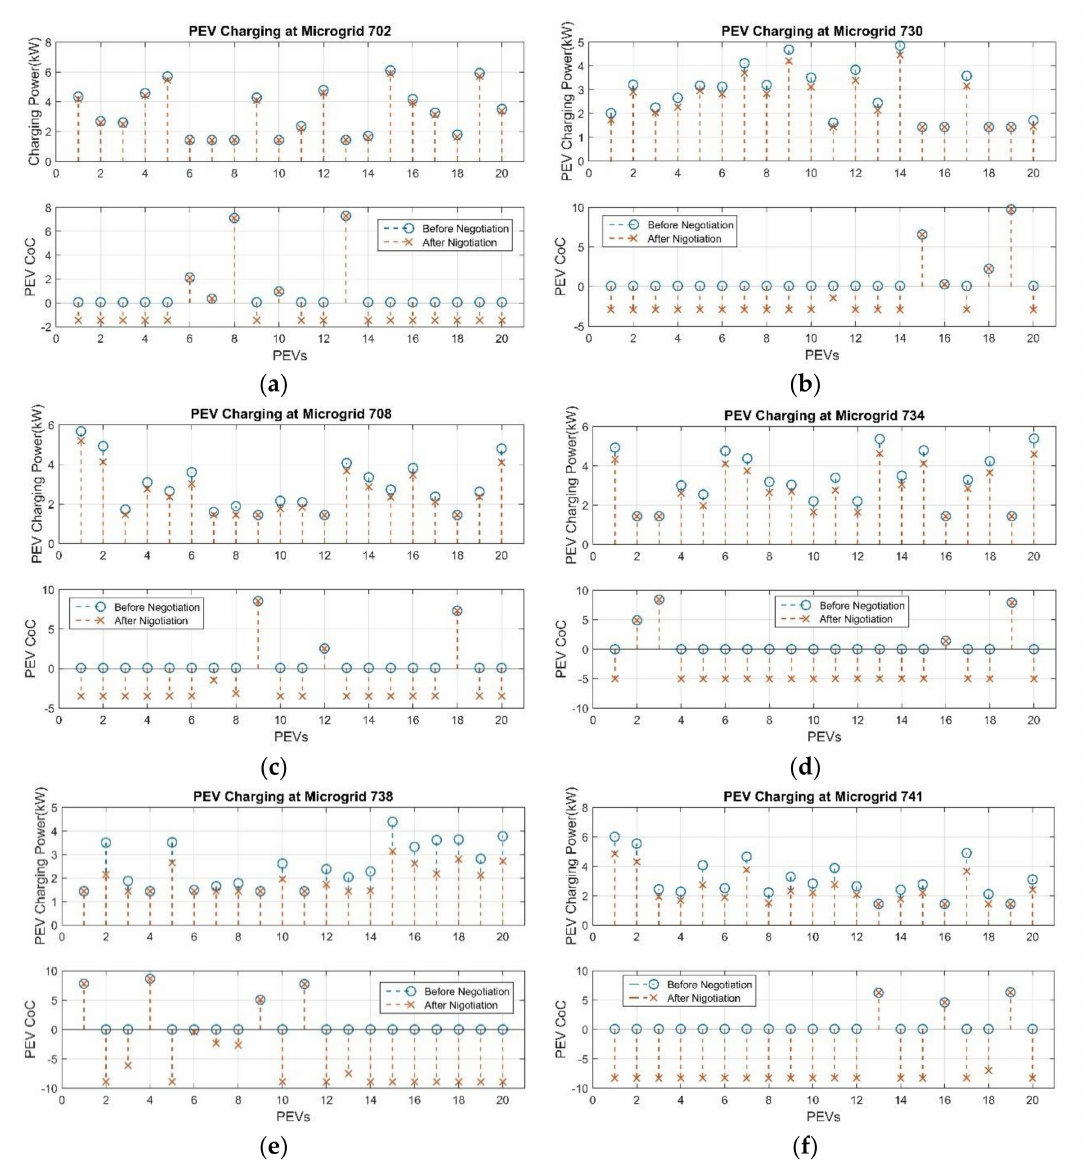
Figure 9. The negotiation e ff ects on PEV charging in the microgrids. ( a – f ) show PEV Charging power and CoC value comparison before and after the negotiation process in di ff erent VGI Microgrids along the distribution